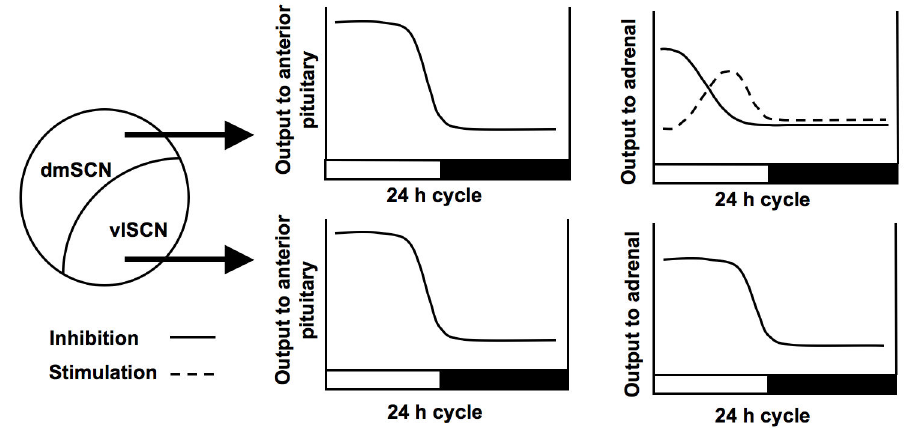
Figure 6. Model of output from SCN subregions to the anterior pituitary and adrenal glands. During the light phase, the dmSCN and vlSCN inhibit ACTH release from the pituitary, while the dmSCN slowly increases plasma corticosterone through either decreasing inhibitory, or increasing stimulatory, output to the adrenal. At the same time, the vlSCN supplies inhibitory output to the adrenals over the light period, keeping plasma corticosterone low until the onset of the dark phase, at which time the pituitary is released from inhibition, resulting in a heightened plasma corticosterone response to